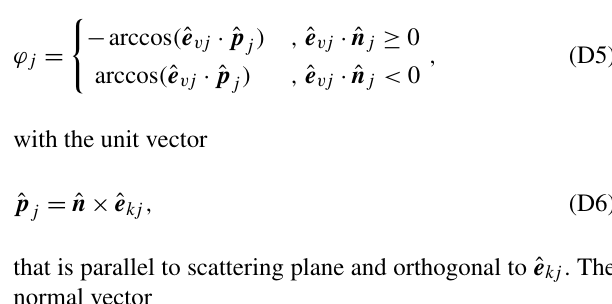
with j = i, s for the incidence direction and the scattering direction, respectively. The rotation angle